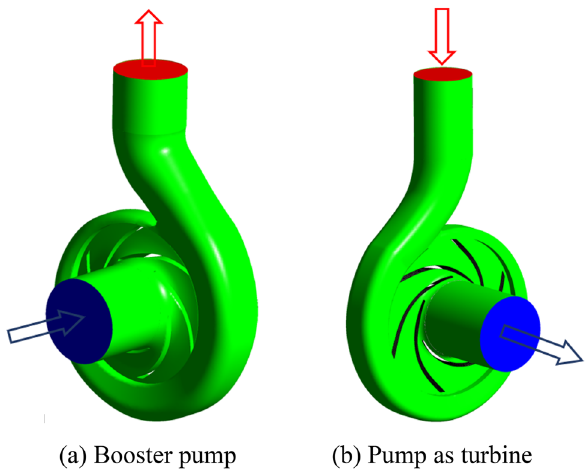
Figure 1. Three-dimensional model. ( a ) Booster pump, ( b ) Pump as